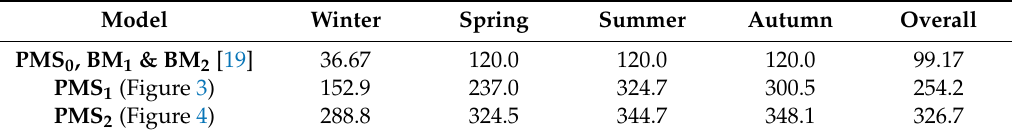
Table 2. Average calibration length window of the NN models (days).